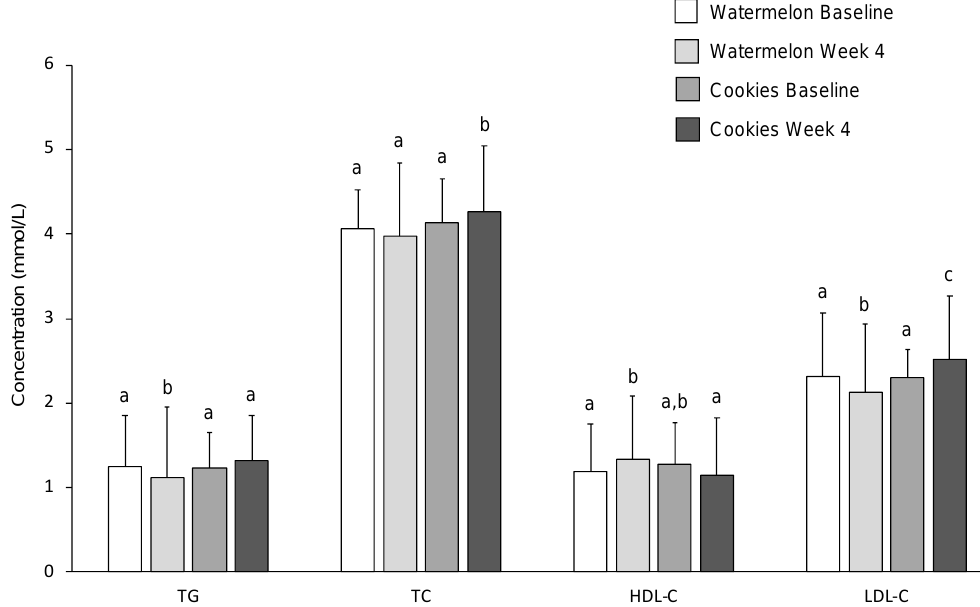
Figure 3. Effects of WM and LFC on serum concentrations of triglycerides (TG), total cholesterol (TC), high-density lipoprotein cholesterol (HDL-C), and low-density lipoprotein cholesterol (LDL-C) at baseline and week 4 of each intervention. Data are presented as means ± SD. Within a variable, values not sharing a common superscript are significantly different at p < 0.05.